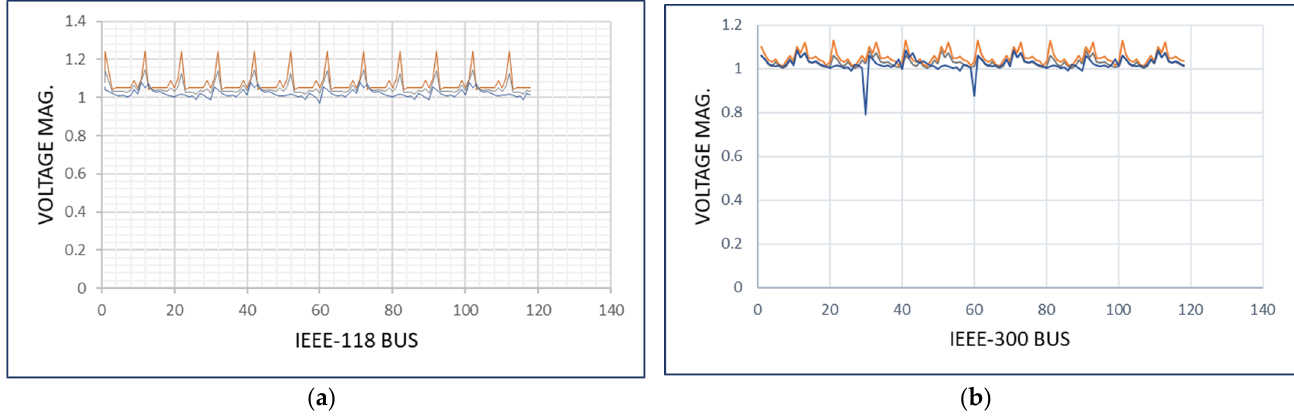
Figure 3. Estimate Data after false data injection attack ( a ) IEEE-118 Bus; ( b ) IEEE-300 Bus.